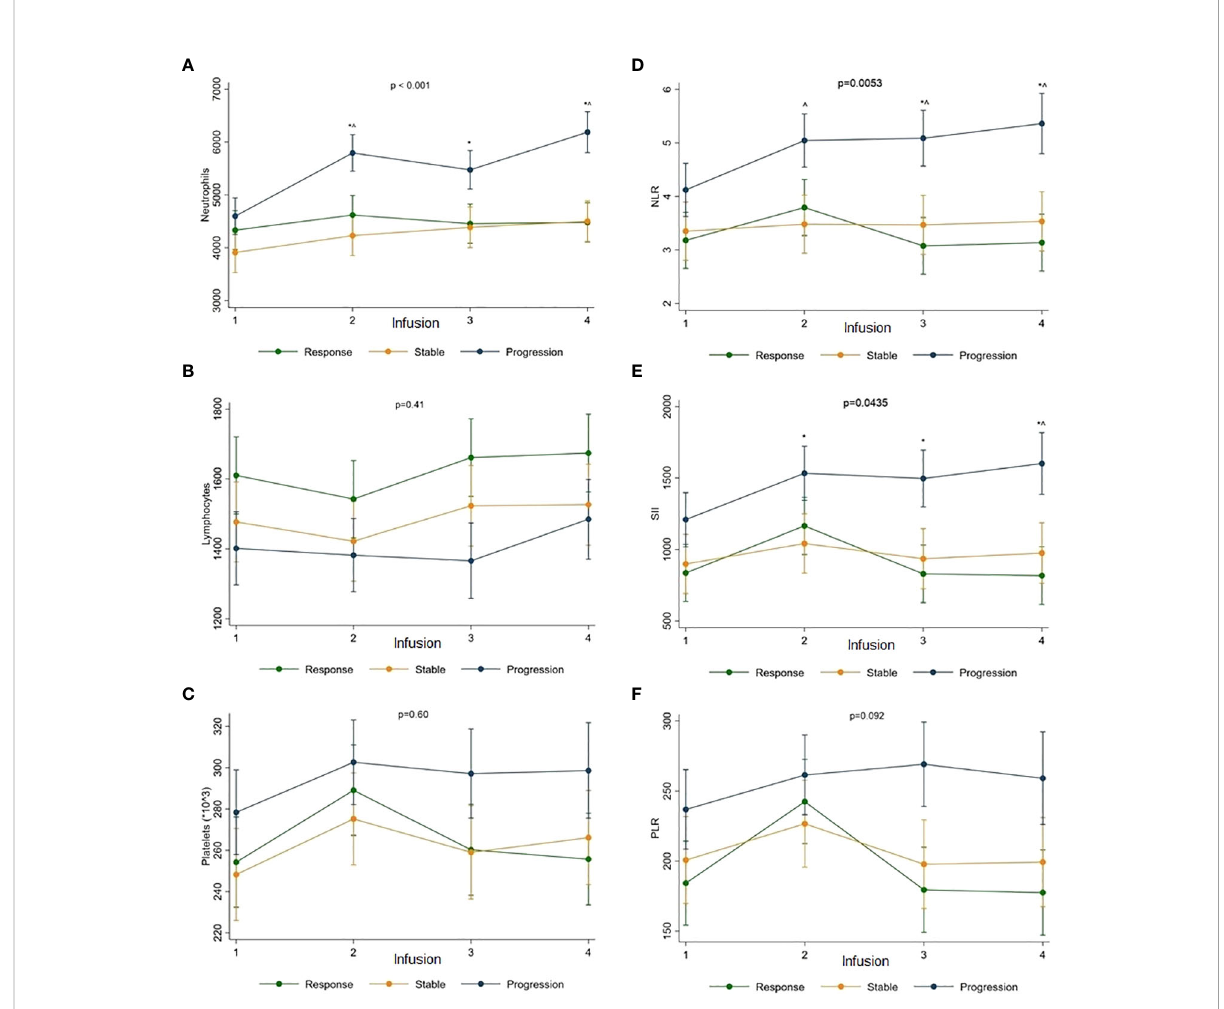
FIGURE 3 The ACC and IR value D according to the disease response to therapy.Neutrophils (A) , lymphocytes (B) , platelets (C) , NLR (D) , SII (E) and PLR (F) were assessed.*Signi fi cant differences compared with response; ^ Signi fi cant difference compared with stable